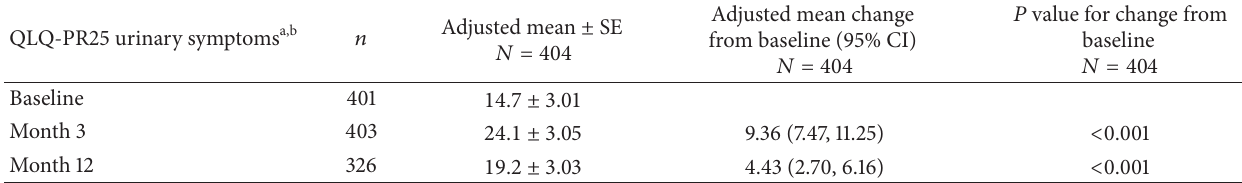
Table 2: Change from baseline in QLQ-PR25 urinary symptoms subscale score (FAS population, observed cases). QLQ-PR25 urinary symptoms a,b